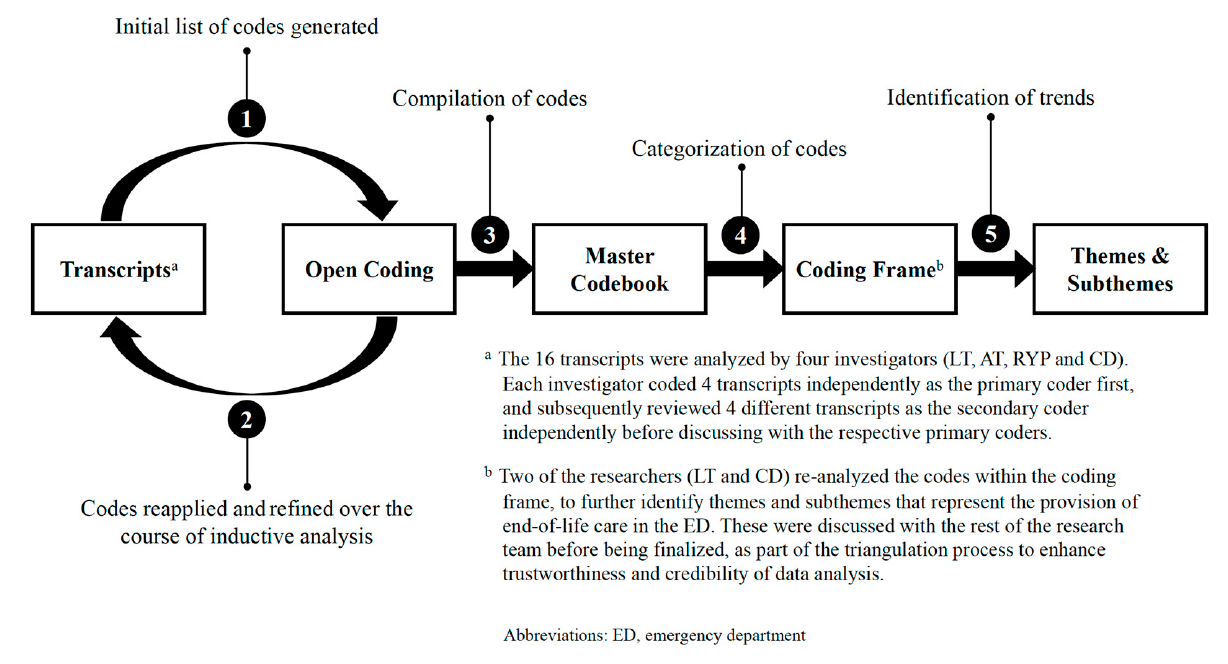
Figure 1. Analysis of data to identify theme.